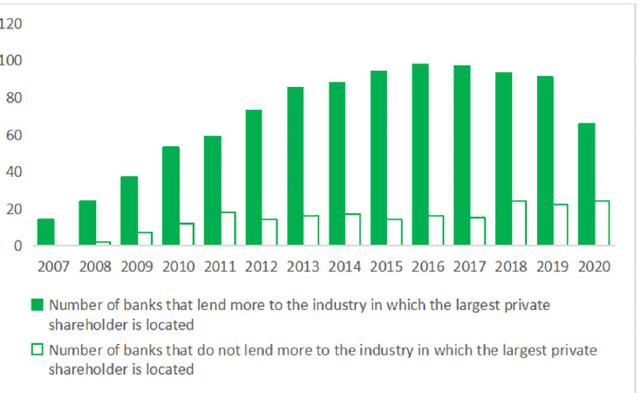
Fig 1. Number of banks that lend more to the industry in which the largest private shareholder is located. The figure plots the number of banks that lend more to the industry in which the largest private shareholder is located (solid bars) vs. the number of banks that do not lend more to the industry (hollow bars) for each year. Based on the proportion of banks’ loans to various industries, we define that banks have made more loans to the top five industries, otherwise, they have